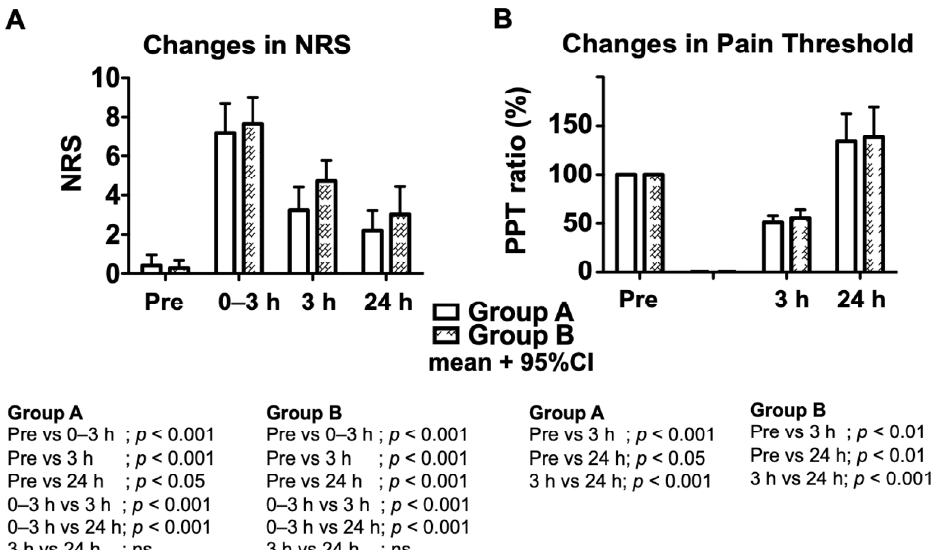
Figure 3. Changes in numeric rating scale score and pain threshold. ( A ), The numeric rating scale score (NRS) was recorded on the day before surgery (preoperative), and at 3 h and 24 h after the end of surgery. The maximum numeric rating scale score during 0–3 h was also recorded at 3 h after surgery. Changes in numeric rating scale scores within each group were analyzed by one-way analysis of variance with repeated measures, followed by Bonferroni post hoc tests. p values of the comparison within each group are listed. ( B ), The pressure pain threshold (PPT) was measured on the day before surgery (preoperative), and at 3 h and 24 h after the end of surgery using a pressure algometer. Changes in pressure pain threshold values within each group were analyzed (assuming that the value on the day before surgery was 100%) by one-way analysis of variance with repeated measures, followed by Bonferroni post hoc tests. p values of the comparison within each group are listed. n = 15. Each bar represents the mean value + 95%